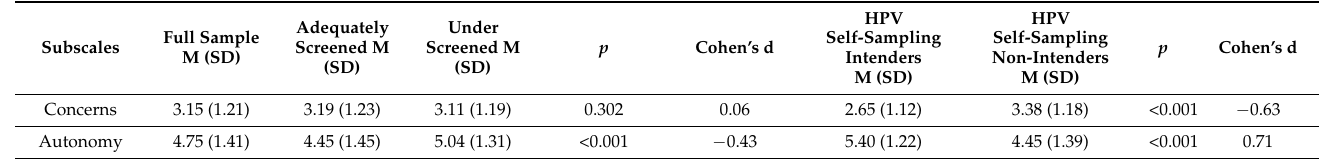
Table 7. Criterion validity analyses for the HPV Self-Sampling Attitudes and Beliefs